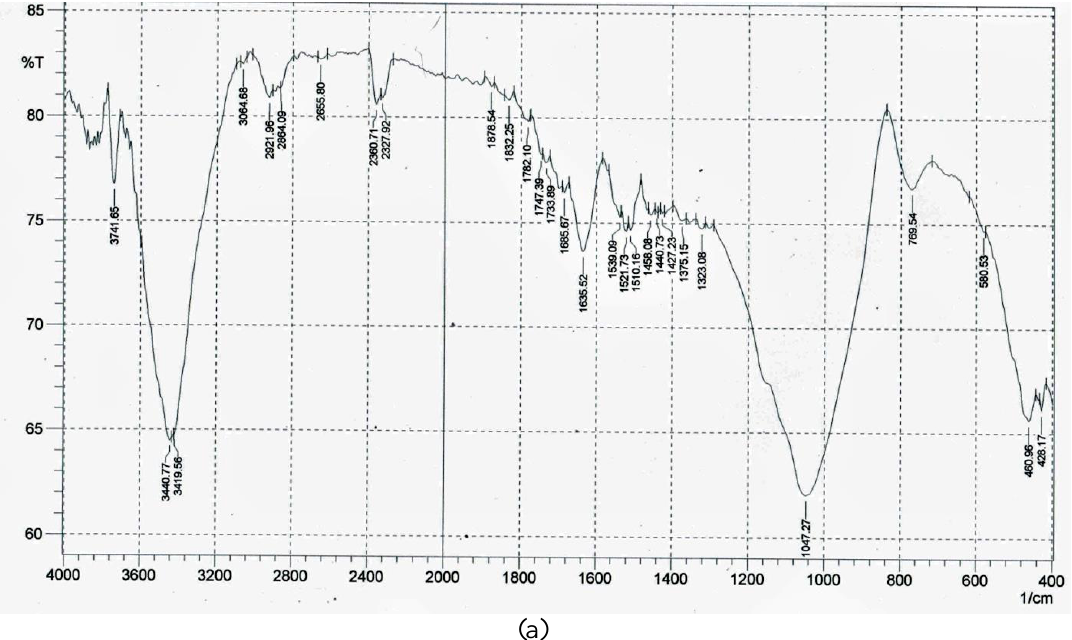
Fig. 6: Typical FTIR spectrum of DLC at a different distance between the substrate and the plasma torch a) 2